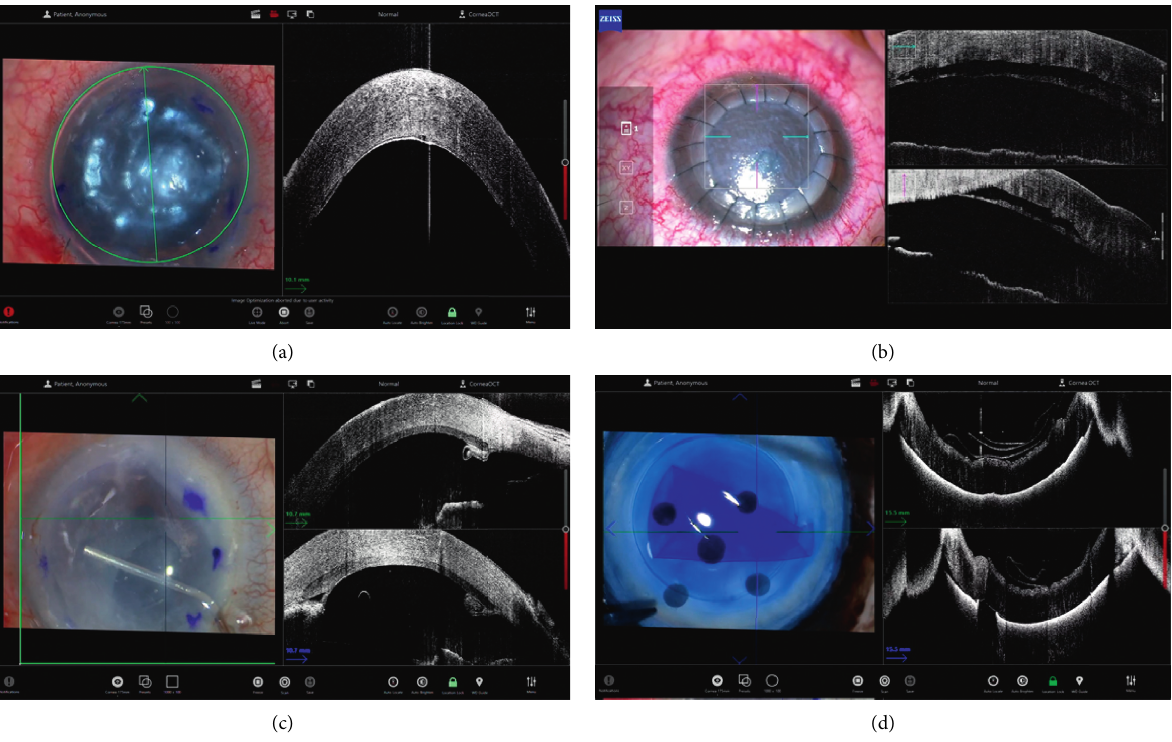
Figure 3: Application of the iOCT in DSAEK and DMEK surgery. (a) Confirmation of the attachment of the endothelial graft during DMEK. (b) Visualization of the detached endothelial graft cornea in DMEK. (c) Visualization of the peripheral anterior synechiae during DSAEK. (d) Visualization of the donor fold before donor graft insertion in